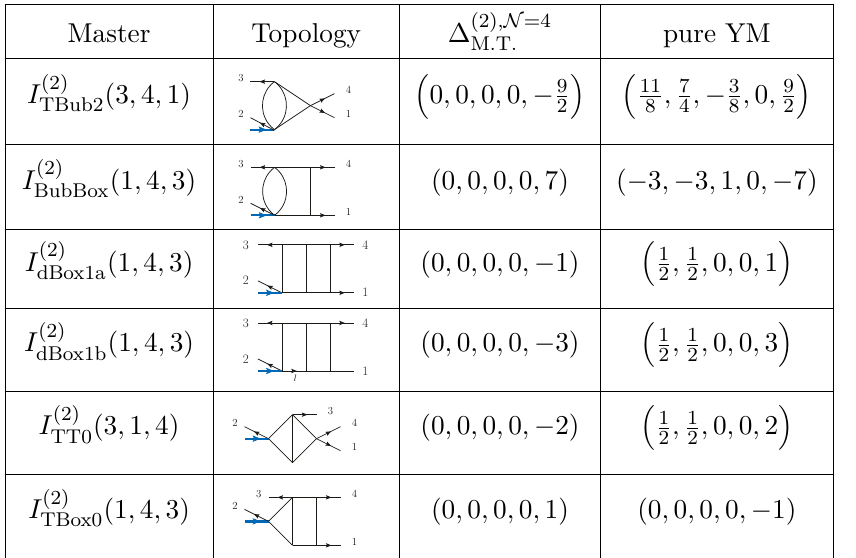
Table 6. The coefficients of the master integrals detected by the unitarity cut shown in figure 13 in = 4 super Yang-Mills and pure Yang-Mills, the vector ( c N Figure 16. Diagrams that contributing to ∆ (2) , N =4 the red